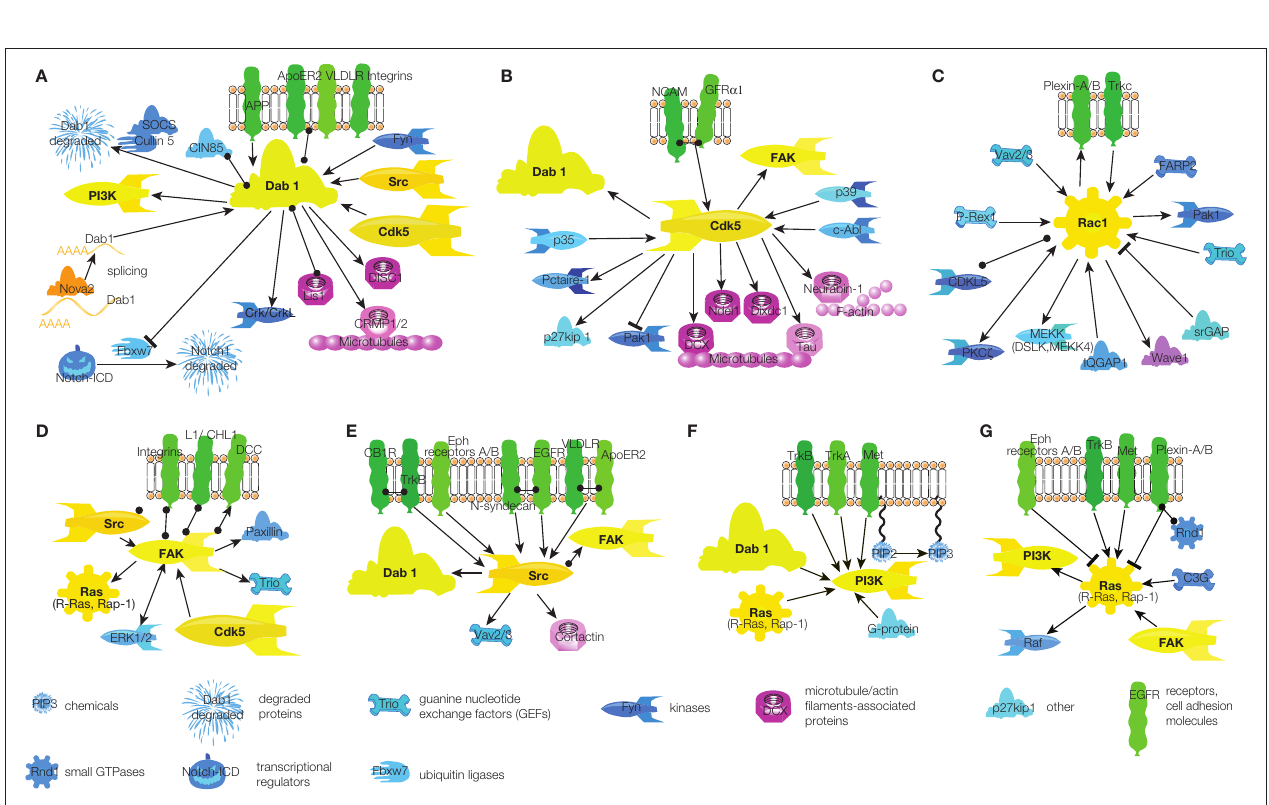
Figure 1 | Signaling network controlling neuronal migration – the scheme is based on experimental data derived from several hundred publications. The only legible names denote network components that constitute “signaling hubs.” The scheme is legible upon downloading Figure S1 in Supplementary Material. (A) Seven hubs in the neuronal migration signaling network (shown in